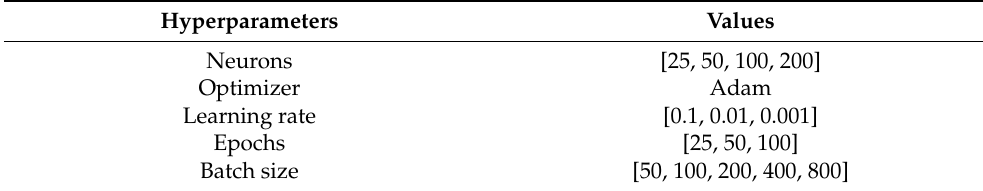
Figure 1. Proposed forecasting model framework using A-MFDFA with RNNs. Table 1. Hyperparameter information for the RNN